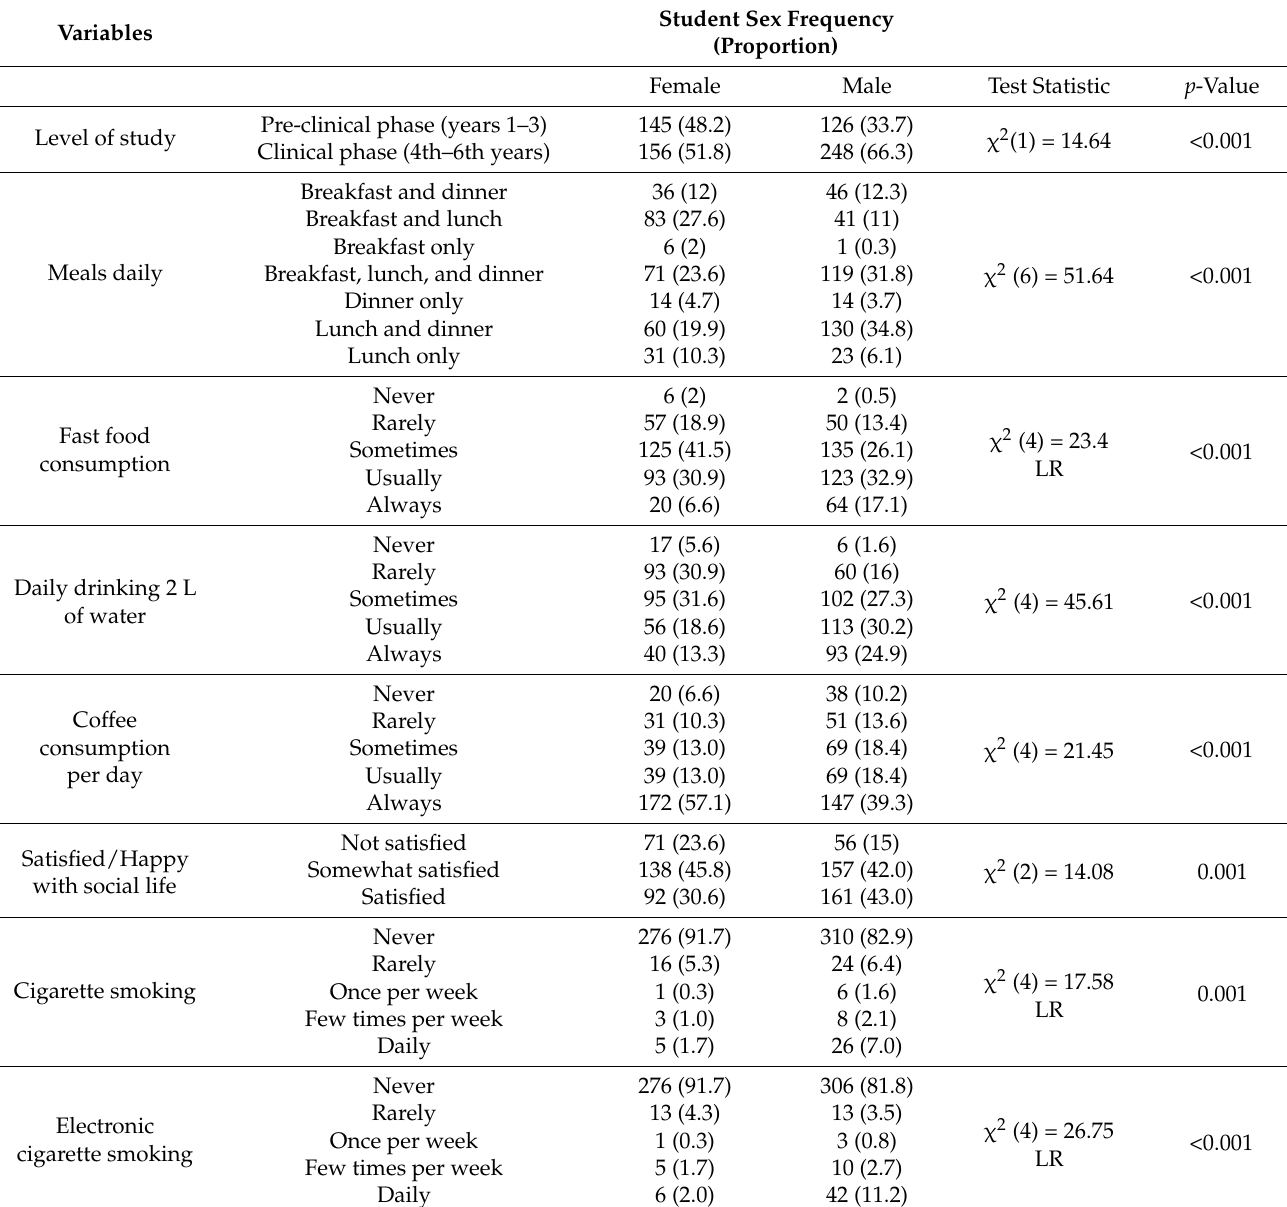
Table 4 showed the bivariate analysis of lifestyle characteristics across sex. The daily eating habits differed significantly between male and female medical students, p < 0.001. Moreover, male students were significantly more inclined to consume fast foods than females, p < 0.001. The majority (63.3%) revealed they usually or always drink black coffee daily. Females were significantly more inclined to regular coffee consumption than males, p < 0.001. Surprisingly, only 4.3% exercised for 30 min or more daily. Male students were significantly more satisfied with their social life than females, p = 0.001. Male medical students were significantly more inclined to daily smoking than female medical students, p = 0.001 according to a likelihood ratio adjusted chi-squared test. Additionally, male medical students were substantially more inclined to e-cigarette use than females ( p < 0.001). Table 4. Bivariate analysis of lifestyle characteristics across sex. N =